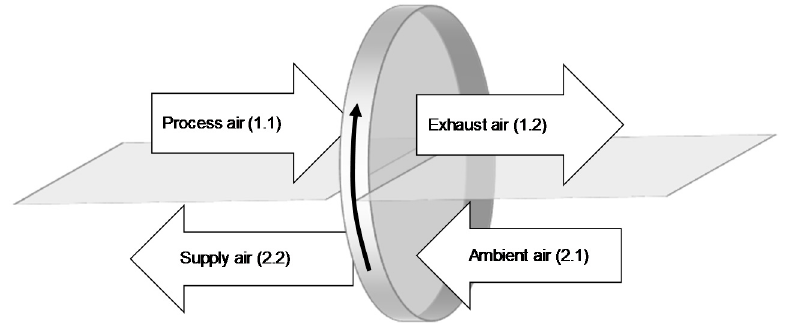
Figure 1. Rotor working principle and stream names.